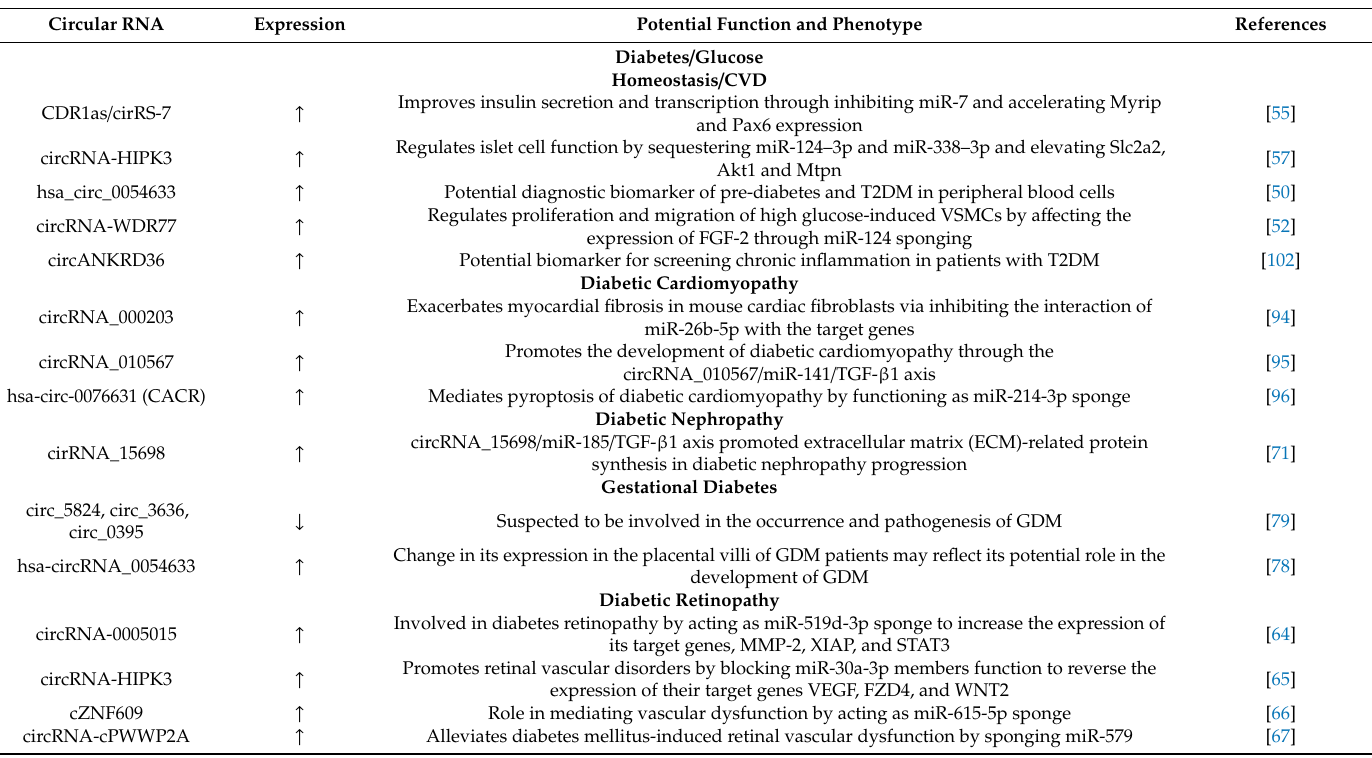
Table 2. Putative functions of relevant circular RNAs in diabetes mellitus and associated vascular complications. Circular